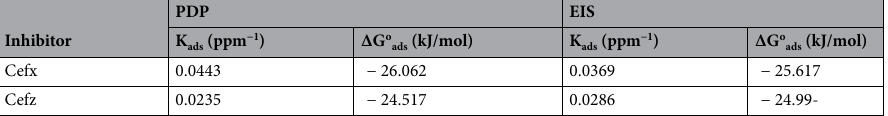
Table 7. Thermodynamic parameters of adsorption process based on the best fitted adsorption isotherm calculated from PDP and EIS measurements at 293 K.